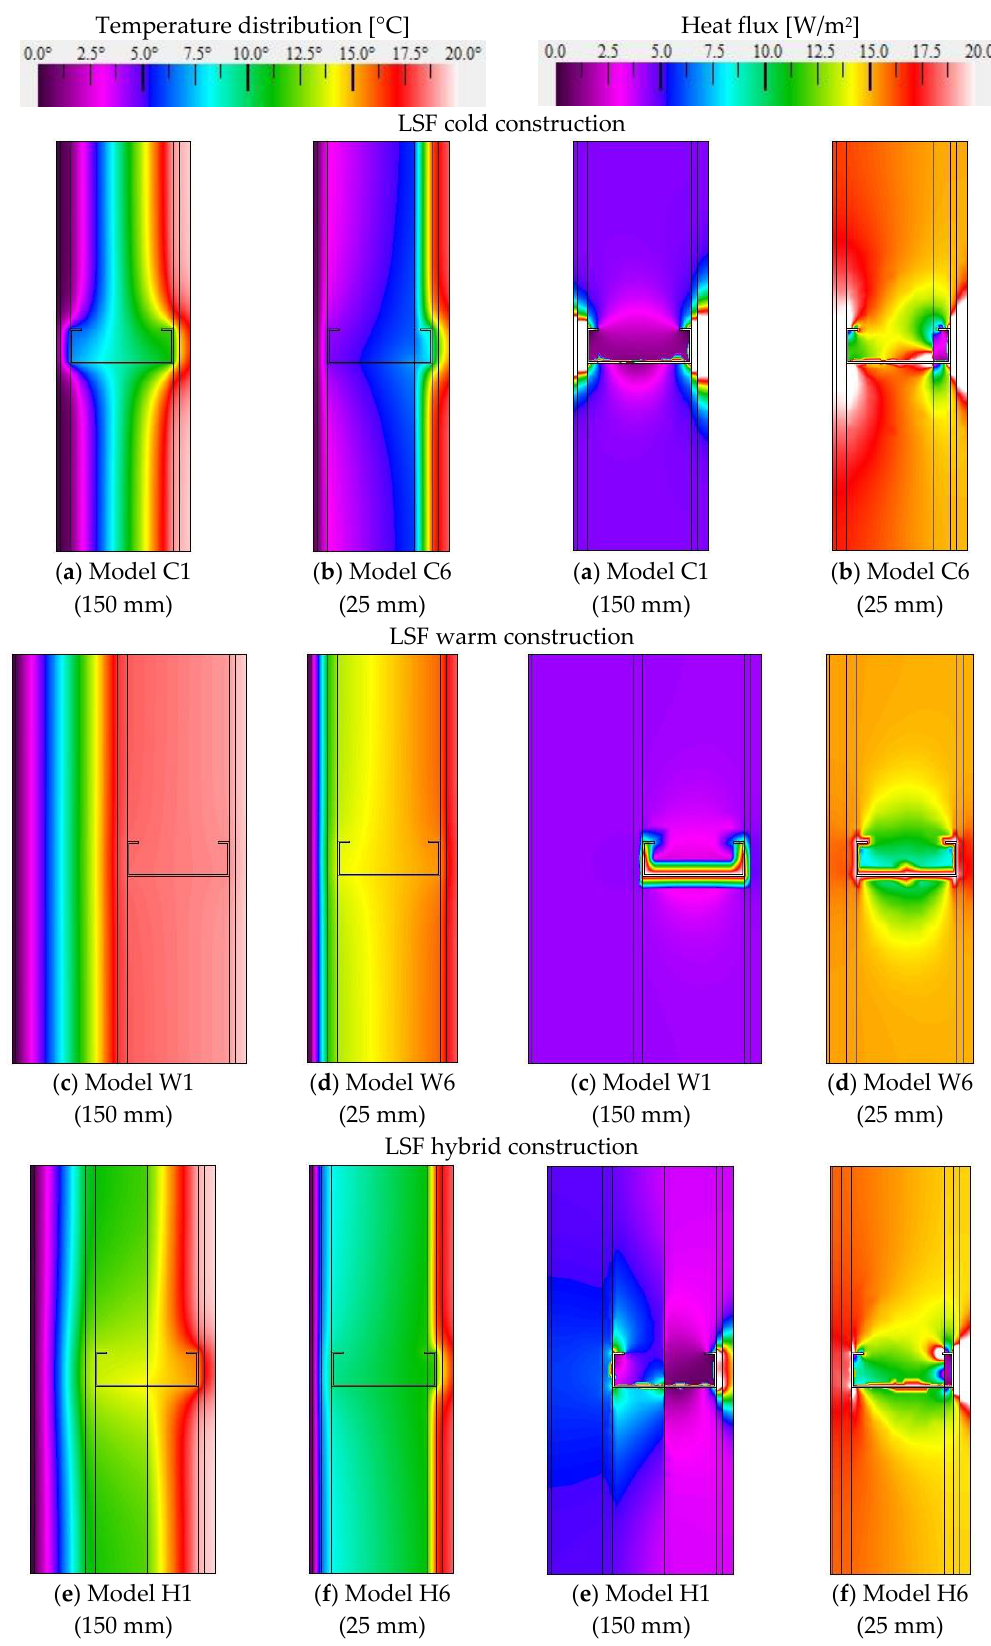
Figure 8. Flux magnitude and temperature distribution.